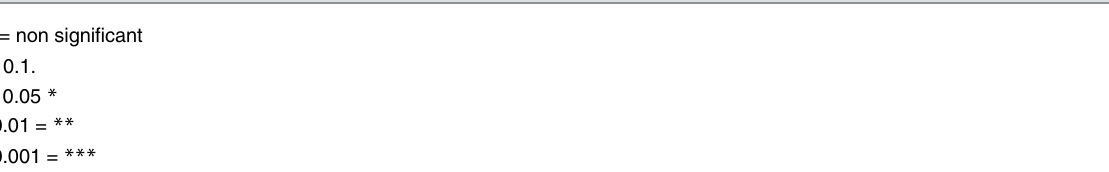
Table 2. Analysis of deviance table, listing the overall results of the Poisson distributed generalized linear mixed effect models (GLMM) investigat- ing the seasonal importance of forest areas near grassland recording sites for bat species richness and activity. Forest area P Forest distance P Species Month LR χ 2 4 = 133.3 *** LR χ 2 4 = 137.9 *** Richness Forest area LR χ 2 1 = 25.8 *** LR χ 2 1 = 9.36 ** Forest area * Month LR χ 2 4 = 16.8 ** LR χ 2 4 = 5.5 n . s . Activity Month LR χ 2 4 = 1272.6 *** LR χ 2 4 = 1252.6 *** Forest area LR χ 2 1 = 34.8 LR χ 2 1 = 9.2 Forest area * Month LR χ 2 4 = 132.8 LR χ 2 4 =